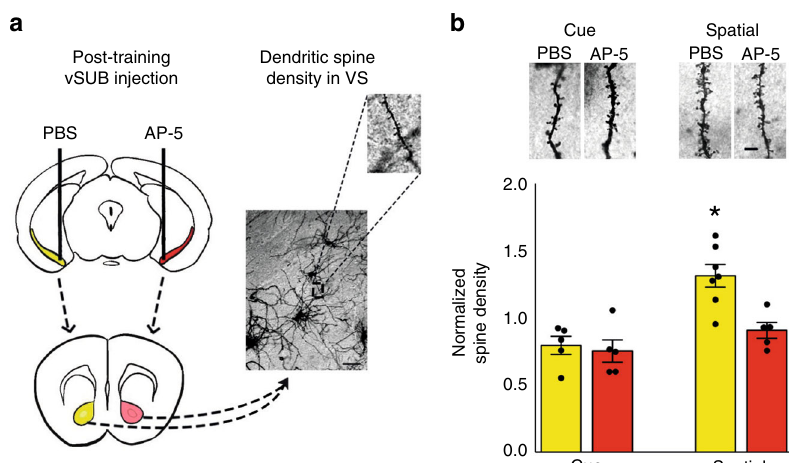
Fig. 3 Spatial learning-induced increase in VS spine density is vSUB-dependent. a Schematic representation of the experimental design. Scale bar: 50 µ m. b Representative microphotographs of dendritic segments of a MSN in the VS for each experimental condition. Mean dendritic spine density/ micrometer for cue and spatial trained mice was normalized to naïve mice ( n = 6). Spatial training signi fi cantly increased spine density in the VS ipsilateral to the vehicle-injected vSUB ( n = 7) as compared to cMWM ( n = 5) trained mice. No change was observed in the AP-5 administered hemisphere ( n = 5) (two-way ANOVA of training F 1,18 = 18.162, p = 0.0005; treatment F 1,18 = 8.056, p = 0.0109; training × treatment F 1,18 = 5.329, p = 0.0331). Scale bar: 5 µ m. Histograms represent mean ± SEM; * p < 0.05 spatial vs cue